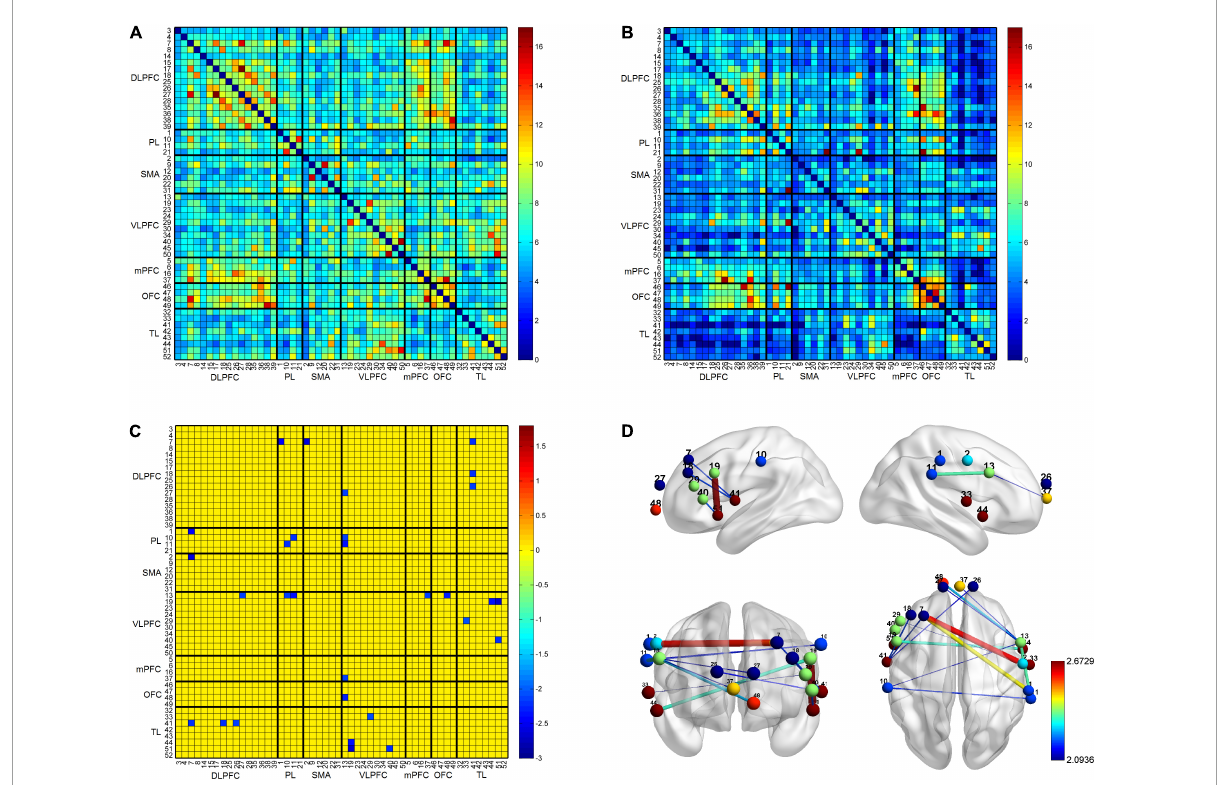
FIGURE3 The results of the RSFC pattern within and between non-caregiver and informal PD caregiver. The RSFC within and between the bilateral frontal, parietal, and temporal lobes was markedly increased in the non-caregiver group (A) ( p < 0.05, FDR corrected) and showed a lower increase in the informal PD-caregiver group (B) ( p < 0.05, FDR corrected). Group comparison showed the RSFC decreased in informal PD caregiver within the bilateral IPL and between the left DLPFC and the right IPL, the right SMA, the right VLPFC, and the left TL, between the left VLPFC and the bilateral TL, between the right VLPFC and the left OFC, the mPFC, and the bilateral IPL, and between the right DLPFC and the left TL (C,D) ( p < 0.05,